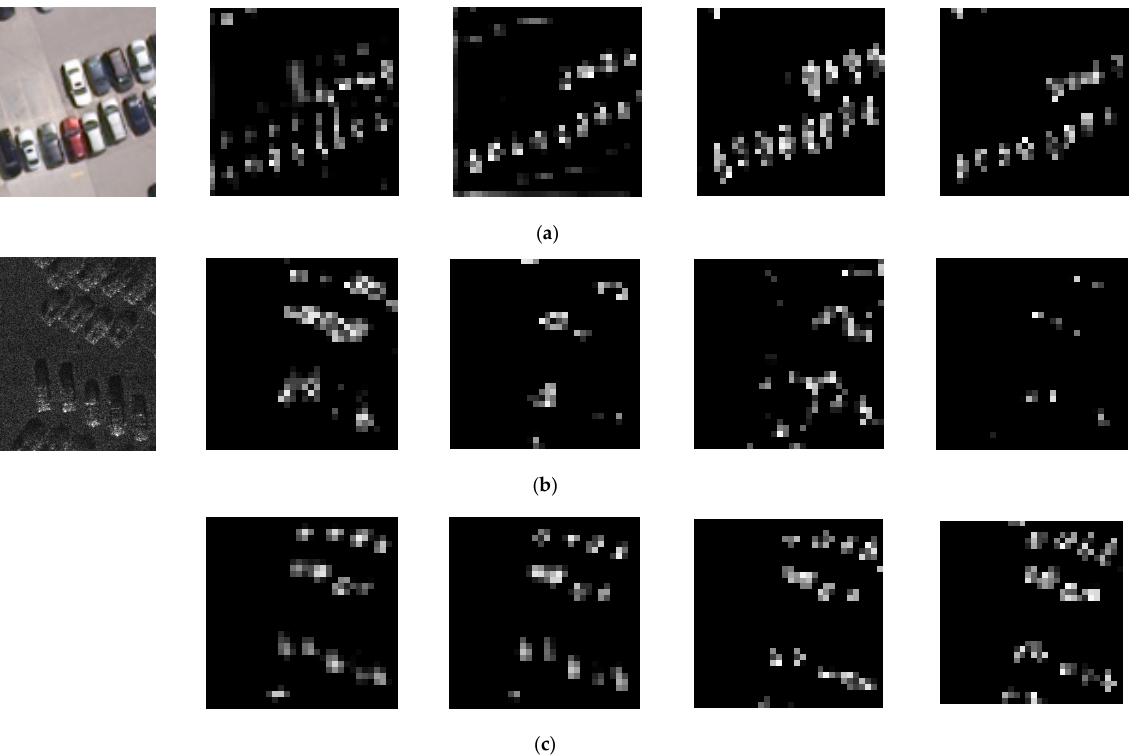
Figure 10. Examples of the feature maps from 4 channels in the conv5_3 layer for image chips. The first column of ( a ) shows the original image chip in the Toronto test dataset, the other four columns of ( a ) are its feature maps obtained by the faster R-CNN. The first image of ( b ) displays the original image chip in the miniSAR test dataset and the other four images of ( b ) are the feature maps obtained by the original faster R-CNN; ( c ) shows the four corresponding feature maps obtained by the faster R-CNN with MMD.